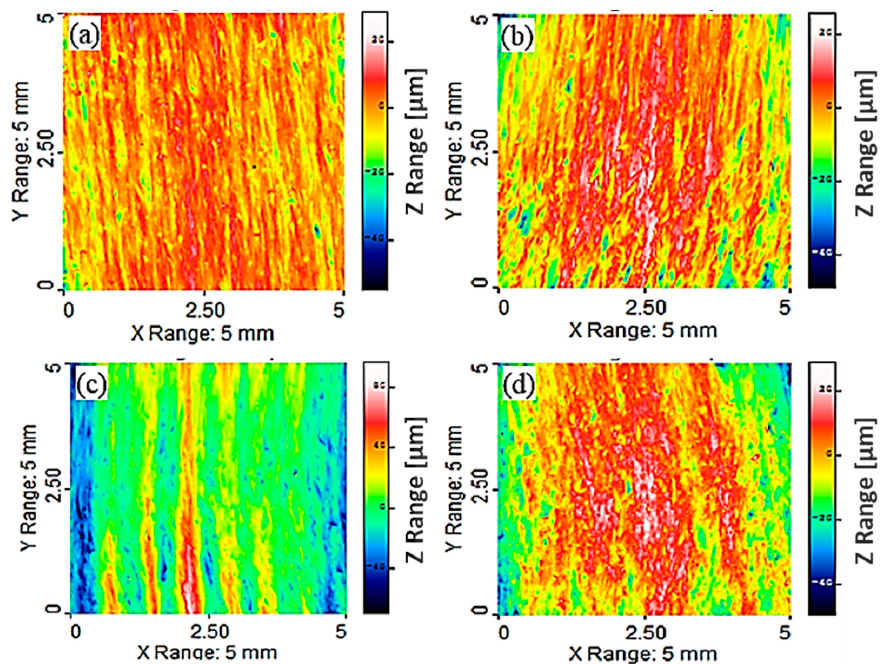
Figure 2. Surface topographical image of sample ( a ) A1; ( b ) A2; ( c ) A3; ( d ) A4 after experiment. Machined surface profiles of Mg-6Al/1.11 Al 2 O 3 under different machining